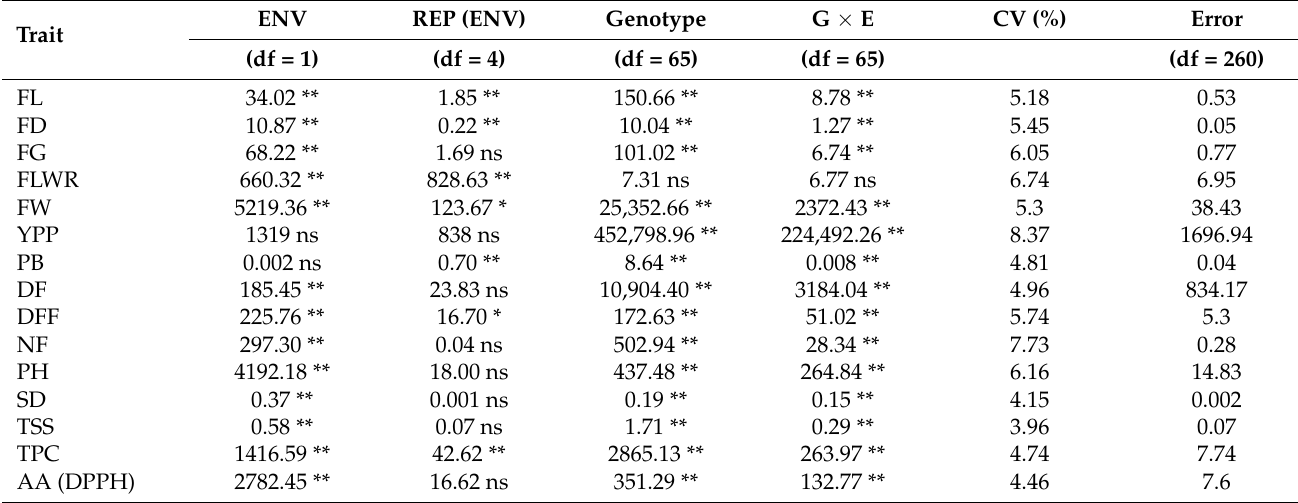
Table 3. Mean squares of analysis of variance for 15 traits of parents and crosses.